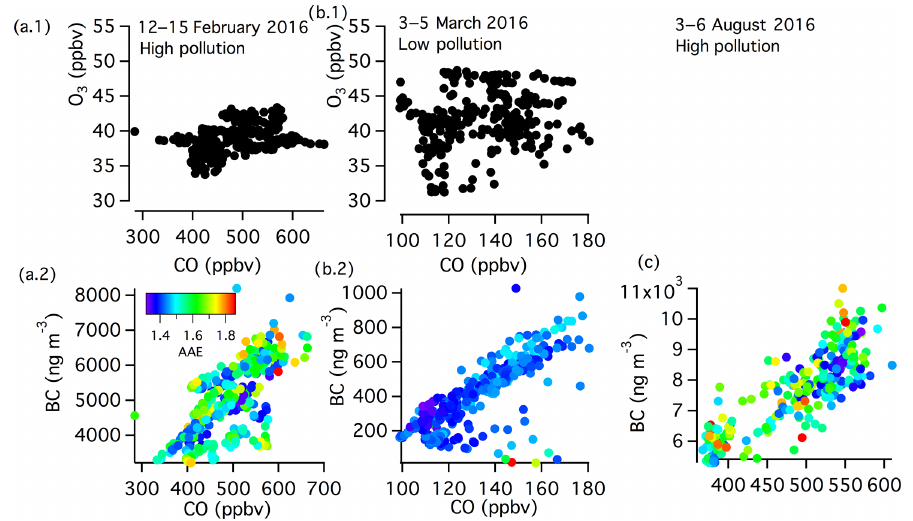
Figure 9. Polluted period in DJF (a) , non-polluted period in MAM (b) , and polluted period in JJA (c) . Comparison of O 3 and CO in (a.1) and (b.1) and comparison of BC and CO, color-coded by AAE, in (a.2) , (b.2) , and (c) for each respective period.